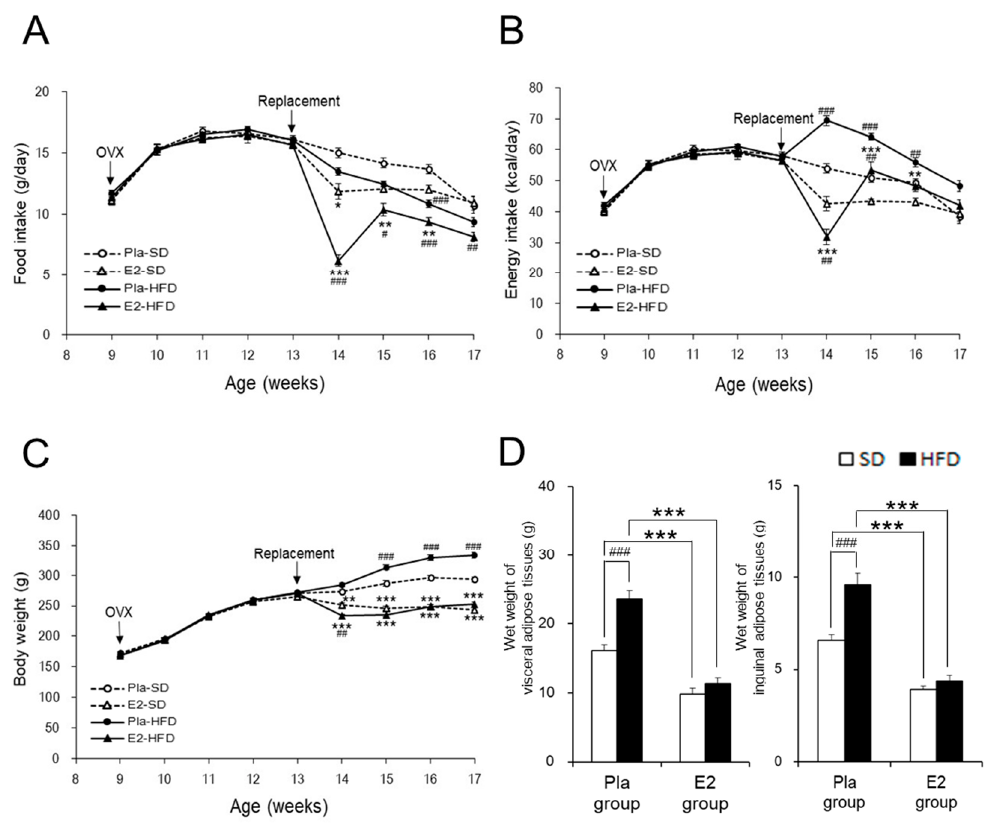
Figure 1. Characterization of the studied rats. Data are expressed as means ± SE. Line graphs